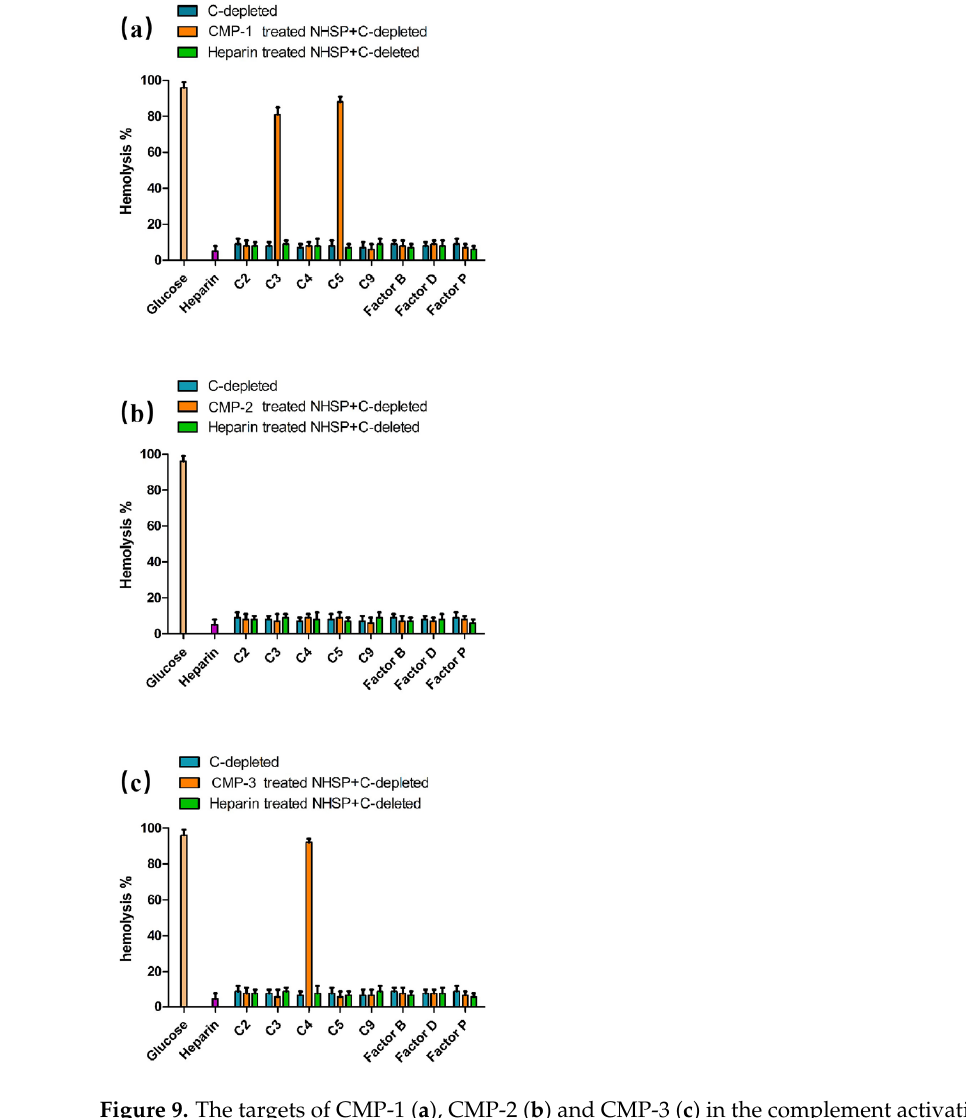
Figure 9. The targets of CMP-1 ( a ), CMP-2 ( b ) and CMP-3 ( c ) in the complement activation